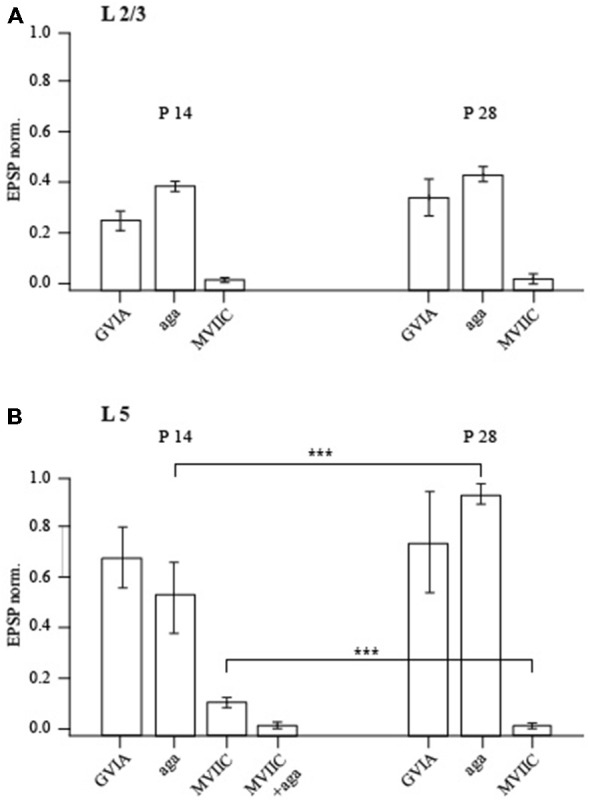
Effect of calcium channel-blocking toxins on synaptic efficacy. Bar histograms show the effects of P/Q-type, N-type and P/Q/N-type calcium channel-specific toxins on evoked unitary EPSPs recorded in layer 2/3 (A) and layer 5 (B) FS neurons in P14 and P28 rats. The ordinate represents (in %) the ratio of mean EPSP amplitude in the steady state during and before toxin application. Asterisks indicate significant difference.